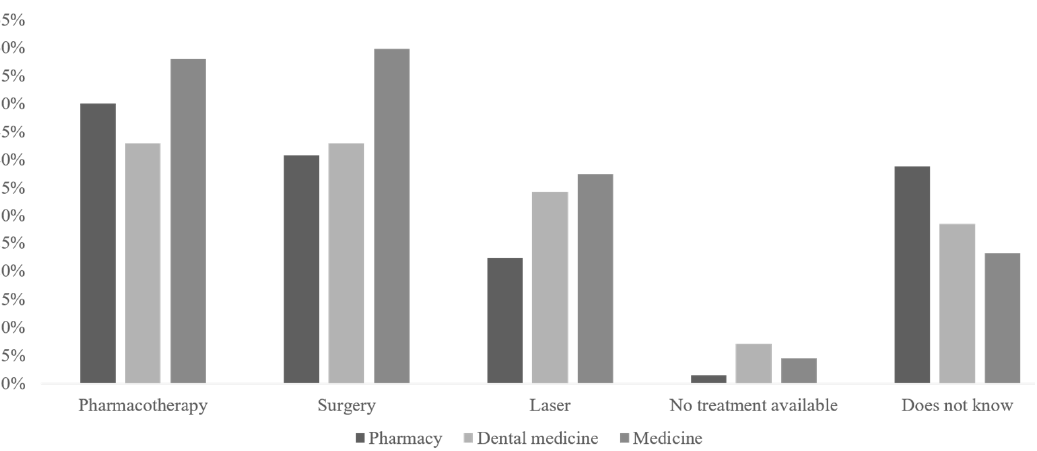
Figure 1. Students’ knowledge of glaucoma treatment. N (pharmacy) = 130. N (dental medicine) = 70. N (medicine) = 112